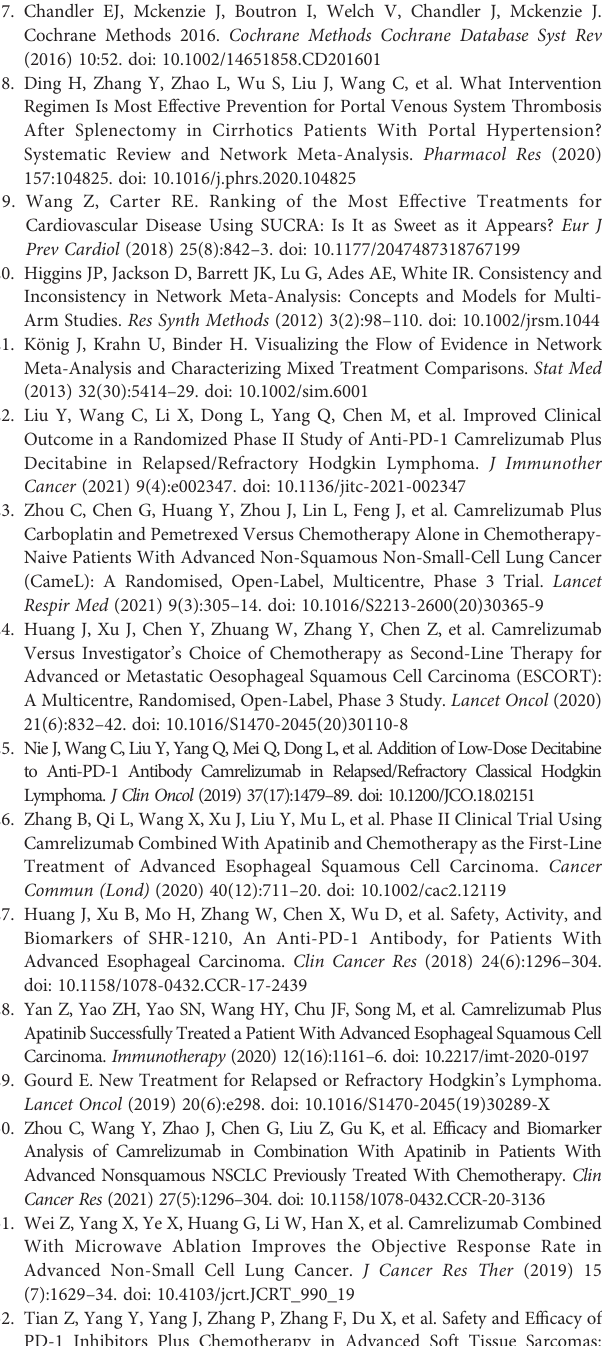
Supplementary Figure 1 | Risk of bias summary. Supplementary Figure 2 | Netfunnel of objective response